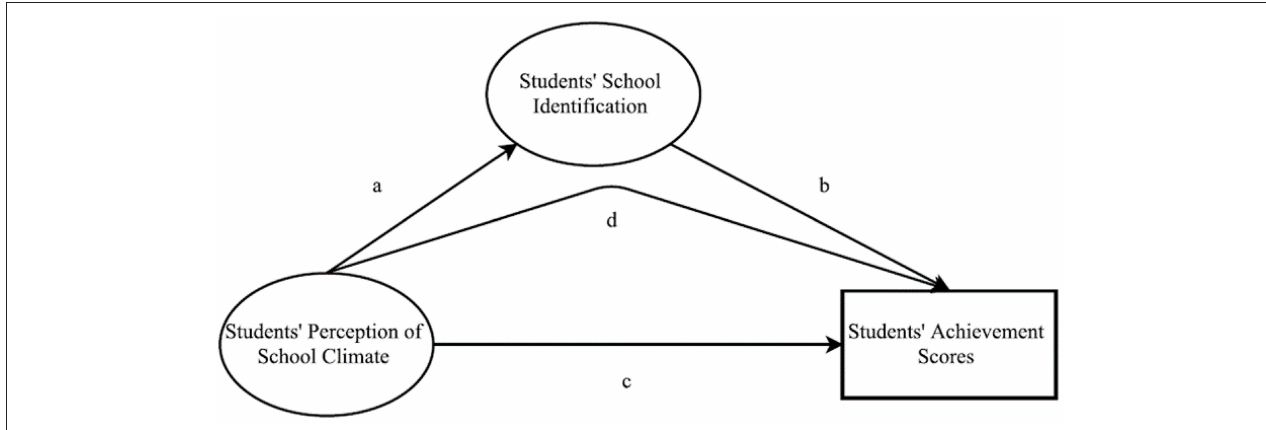
FIGURE 1 | Conceptual model for Hypothesis 1: c = the direct path from students’ perceptions of school climate to students’ NAPLAN results will be positive and significant. Conceptual model for Hypothesis 2: a = students’ positive school climate will predict stronger school identification among students, b = the path from students’ school identification to students’ NAPLAN results will be significant and d = the indirect path from school climate to student achievement scores via school identification will be positive and significant.